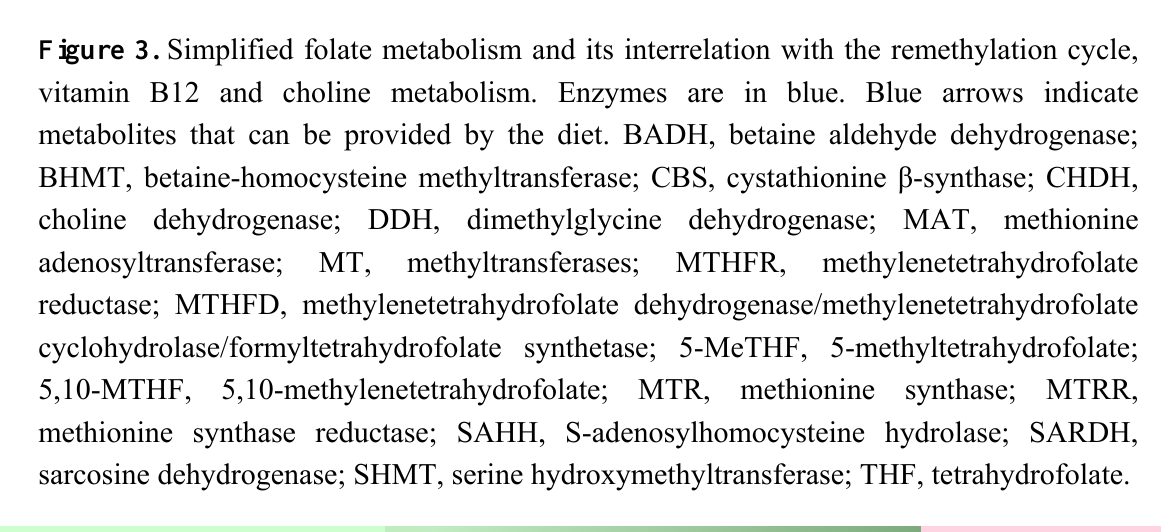
Figure 3. Simplified folate metabolism and its interrelation with the remethylation cycle, vitamin B12 and choline metabolism. Enzymes are in blue. Blue arrows indicate metabolites that can be provided by the diet. BADH, betaine aldehyde dehydrogenase; BHMT, betaine-homocysteine methyltransferase; CBS, cystathionine β -synthase;